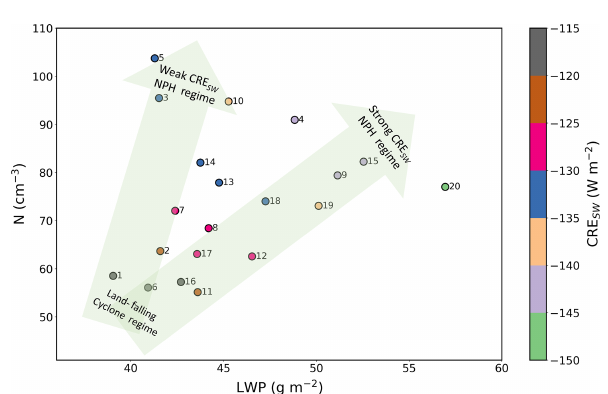
Figure 8. Scatter plot of LWP versus N , colored by CRE SW for each of the nodes. Each value represents the median, and values are taken from Table